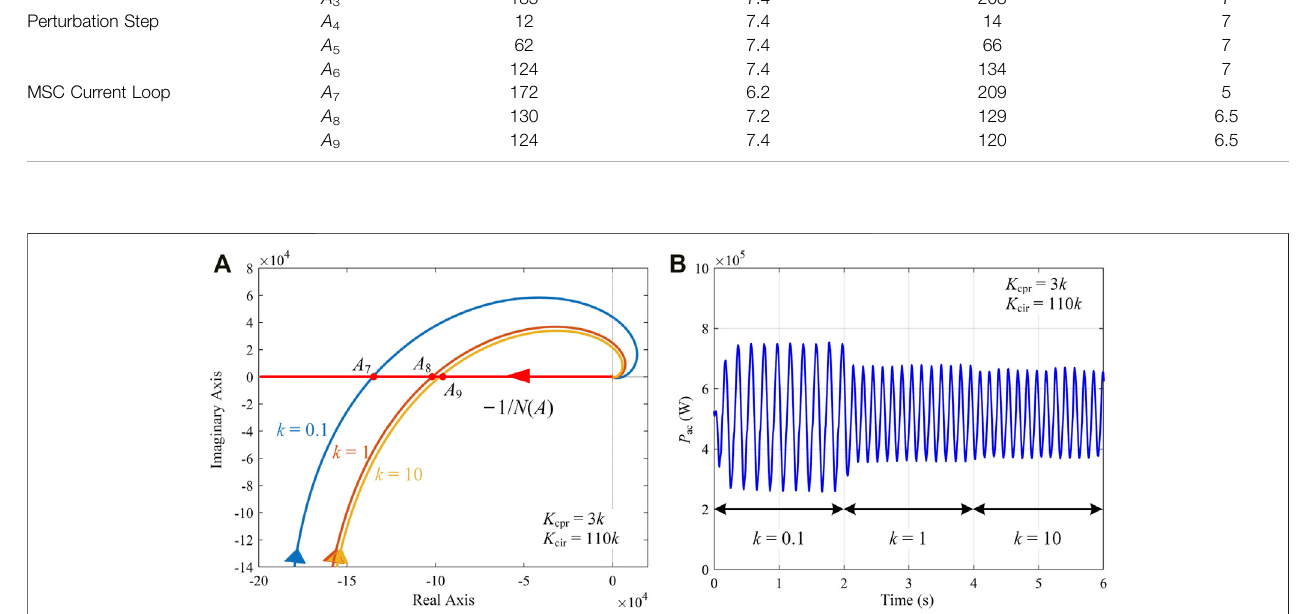
FIGURE 7 | Stability analyses and simulations when changing MSC current-loop parameters K cpr and K cir . (A) Stability analyses based on the DF method. (B) Power output.